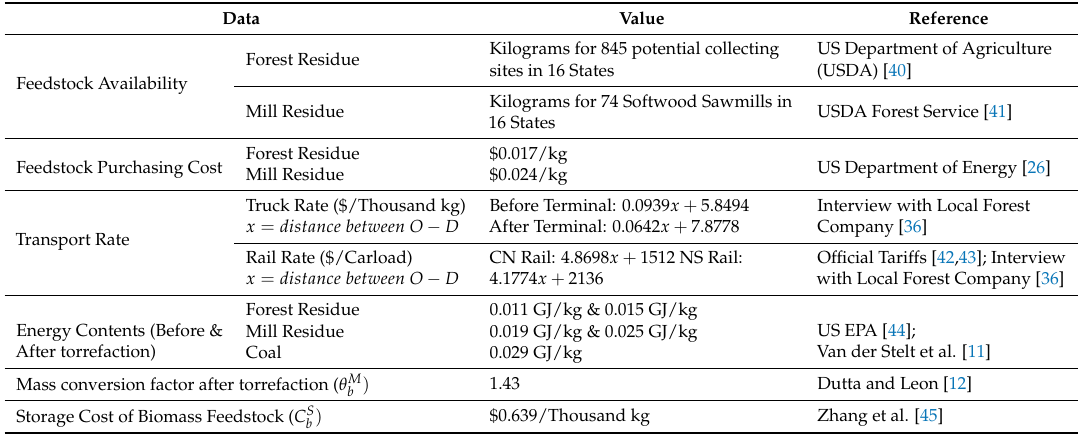
Table A1. Input data for woody biomass feedstock (Ko and Lautala